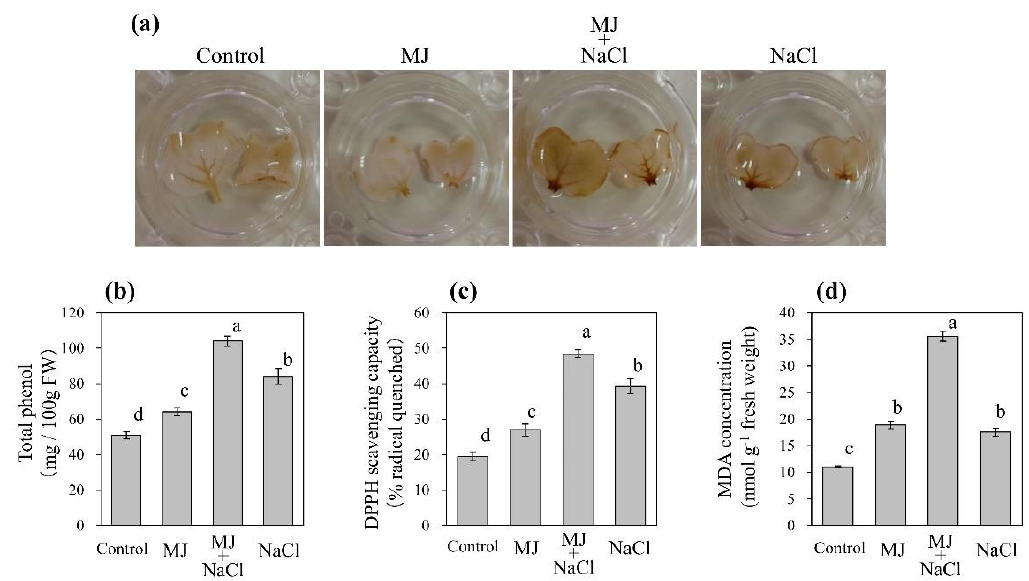
Figure 3. Simultaneous effect of MJ and salinity treatments on oxidative stress and antioxidant parameters in radish sprouts. Hydrogen peroxide production in cotyledons was detected by 3,3’-diaminobenzidine (DAB) stain ( a ), total phenol content ( b ), 1,1-diphenyl-2-picrylhydrazyl (DPPH) radical scavenging capacity ( c ), and malondialdehyde (MDA) concentration ( d ) of sprouts after treatment with MJ (0.5 mM) and/or salinity (200 mM NaCl). Error bars represent ± SE (total phenol content and DPPH; n = 9, MDA; n = 6). Dif ferent letters indicate significant differences by Tukey’s multiple comparison test ( P < 0.05).